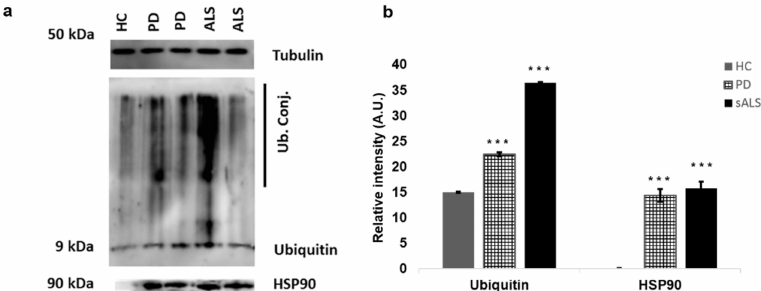
Figure 7. ( a ) Representative western blot data from one HC and two PD- and two sALS-a ff ected patients. The image shows the overexpression of ubiquitin and HSP90 in sALS and PD patients compared to in the HCs. For each analysis, around 15 µ g of protein were loaded. β -tubulin was used as a loading control. ( b ) Quantification of band intensities normalized with a β -tubulin value depicted in (a). Densitometry analysis was performed using the software Image. All western blot experiments were performed in triplicate. *** p <